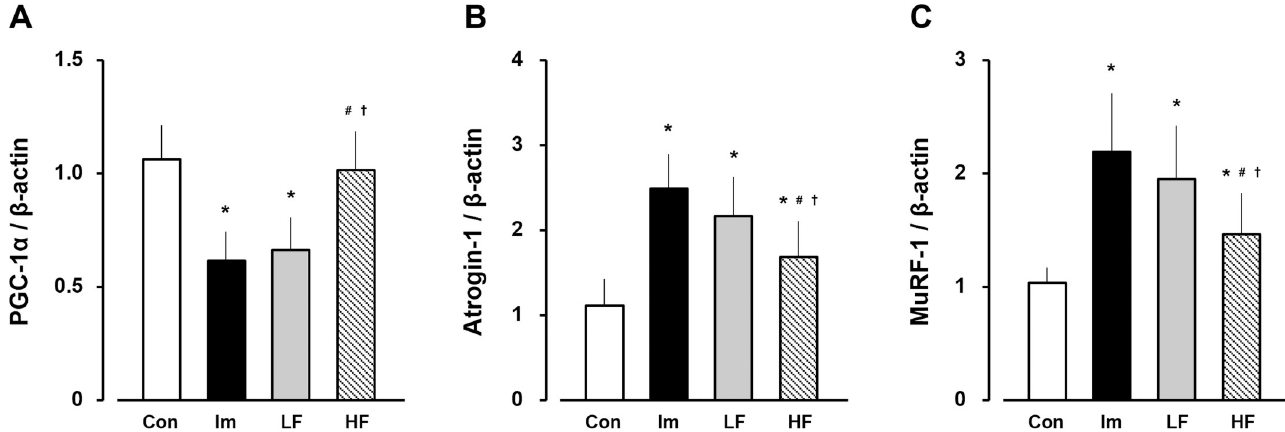
Fig 5. mRNA expression of PGC-1 α (A), Atrogin-1 (B), and MuRF-1 (C) in gastrocnemius muscle. Open bars, control group (control). Black bars, immobilization group (Im). Gray bars, LF group. Hatched bars, HF group. Data are presented as mean ± standard deviation. � Significant difference (p < 0.05) compared to the control group #Significant difference (p < 0.05) compared to the immobilization group. †Significant difference (p < 0.05) compared to the LF group. LF, low-frequency; HF, high-frequency.